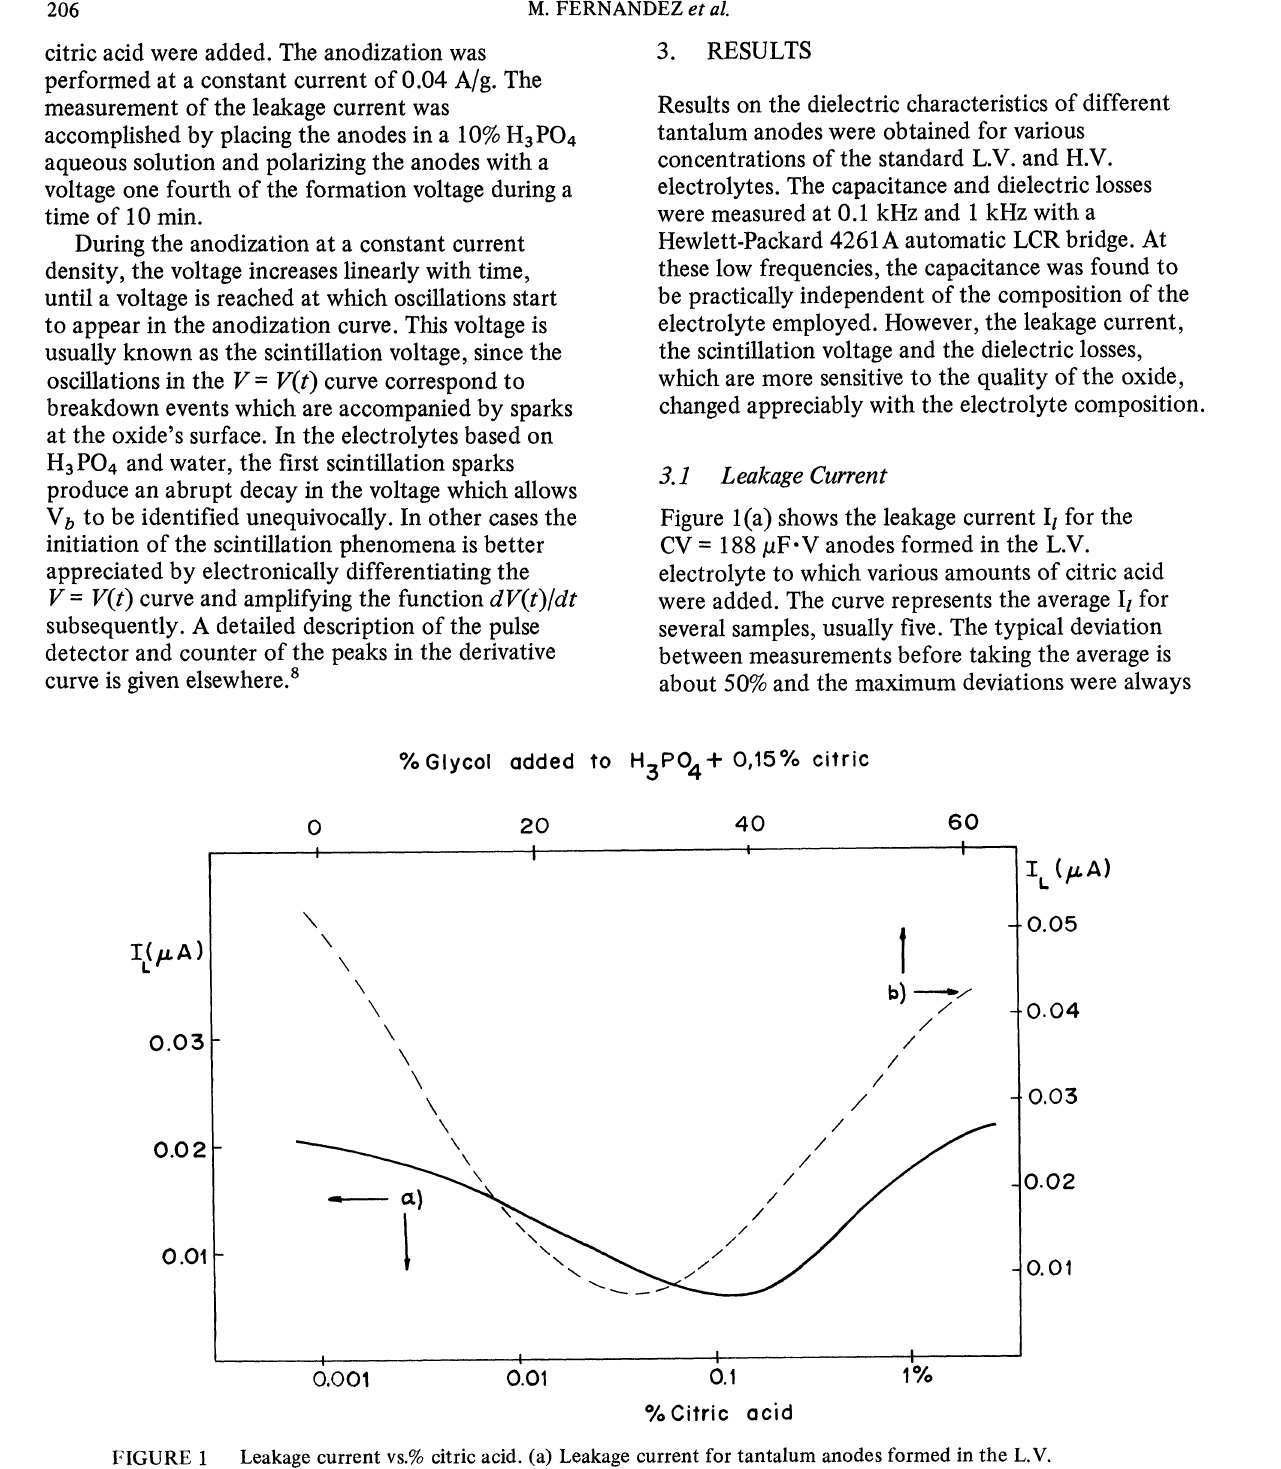
FIGURE Leakage current vs.% citric acid. (a) Leakage current for tantalum anodes formed in the L.V. electrolyte (V[ 170 V) with various amounts of citric acid. (b) Leakage current for anodes formed to 300 V in a H.V. electrolyte of the following composition: 0.15% citric acid, varying concentrations of ethylene glycol in water, and enough H3 PO4 to give p 440